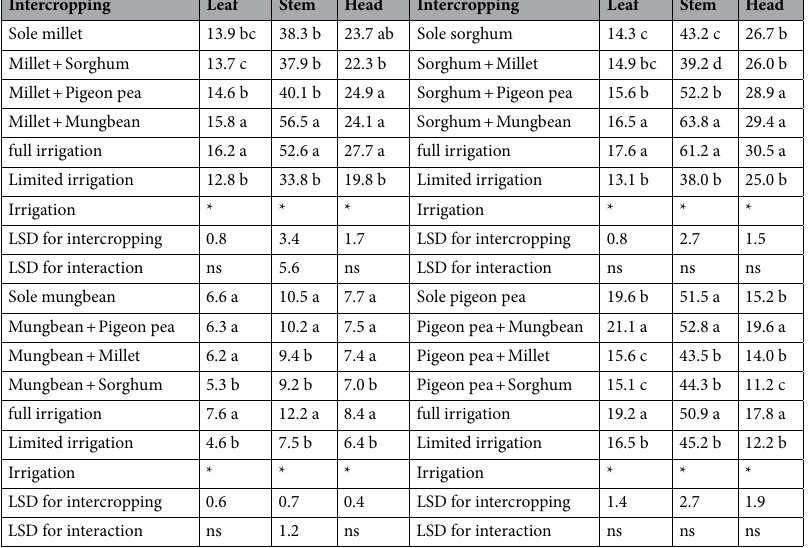
Table 7. Dry matter partitioning (g plant −1 ) at physiological maturity of summer crops as affected by intercropping and irrigation